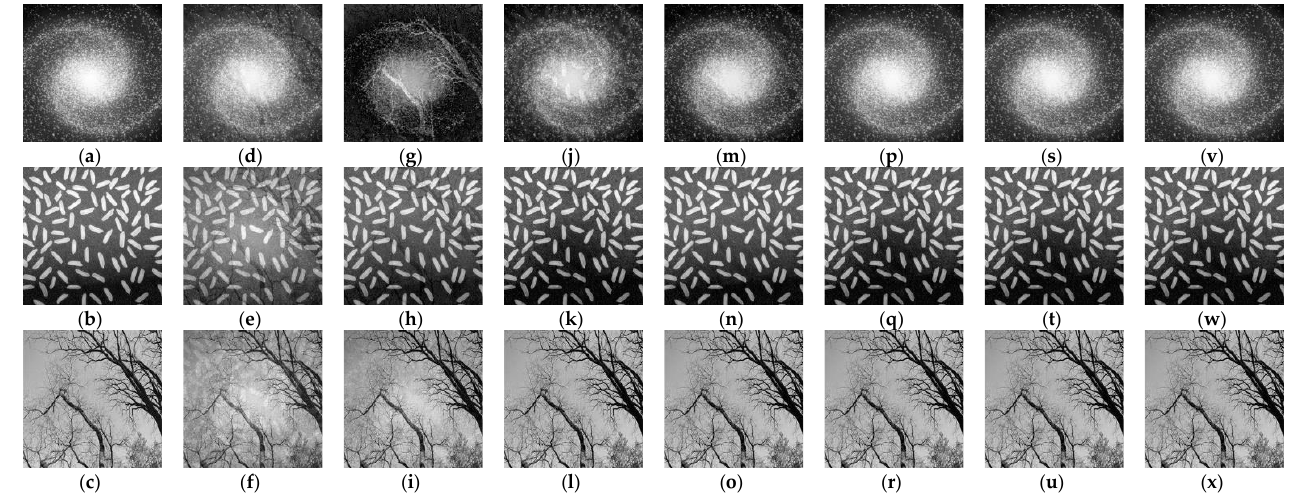
Figure 5. The results of FastICA, PSA, MPSA, NPSA, MSDP and PPSA. The first and second column are the three source images and randomly mixed images as the reference. ( a ) source image 1, ( b ) source image 2, ( c ) source image 3, ( d ) mixed image 1, ( e ) mixed image 2, ( f ) mixed image 3, ( g ) IC1 of FastICA, ( h ) IC2 of FastICA, ( i ) IC3 of FastICA, ( j ) IC1 of PSA, ( k ) IC2 of PSA, ( l ) IC3 of PSA, ( m ) IC1 of MPSA, ( n ) IC2 of MPSA, ( o ) IC3 of MPSA, ( p ) IC1 of NPSA, ( q ) IC2 of NPSA, ( r ) IC3 of NPSA, ( s ) IC1 of MSDP, ( t ) IC2 of MSDP, ( u ) IC3 of MSDP, ( v ) IC1 of PPSA, ( w ) IC2 of PPSA, ( x ) IC3 of PPSA.